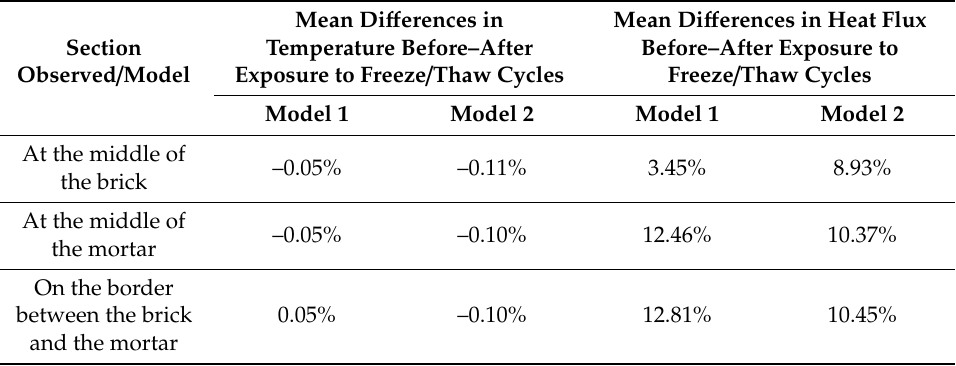
Figure 5. Isothermal contours in model 2: ( a ) Prior exposure to freeze / thaw cycles and ( b ) after exposure to freeze / thaw cycles. Table 6. Percentile di ff erence in the temperature and the heat flux distribution across the cross-section in the x-direction.